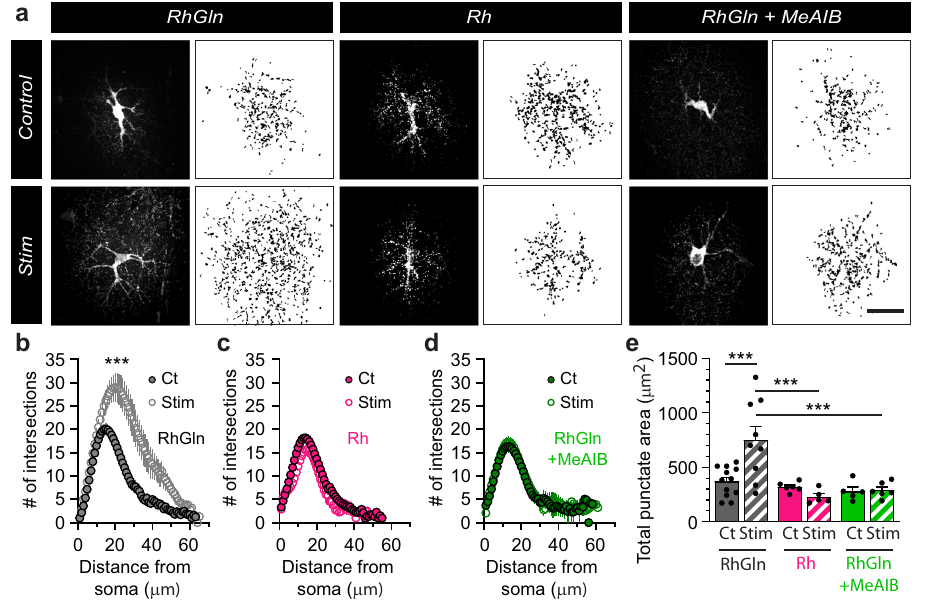
Fig. 3 RhGln is redistributed into subcellular punctate structures. a RhGln or Rh were dialyzed (0.8 mM, 20 min) into a single CA1 hippocampal astrocyte via the patch pipette. Punctate RhGln-labeling surrounding dye- fi lled astrocytes is enhanced by stimulation as shown in representative confocal (dark background) and thresholded binary (white background) images ( a left), quanti fi cation by Sholl analysis (Ct, n = 12; Stim, n = 9, p < 0.0001, two-way ANOVA in b ) and total punctate area ( p = 0.0003 between Ct and Stim, one-way ANOVA with Bonferroni ’ s post hoc test in e ). This was not observed